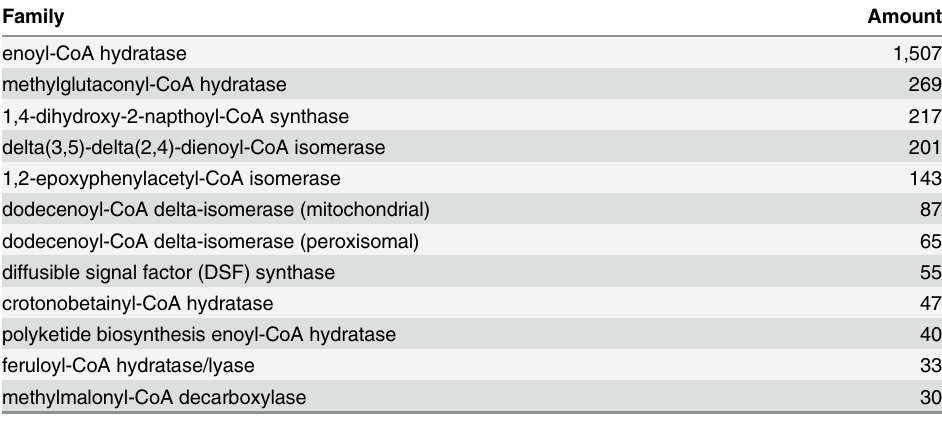
Table 11. Distribution of the crotonases among